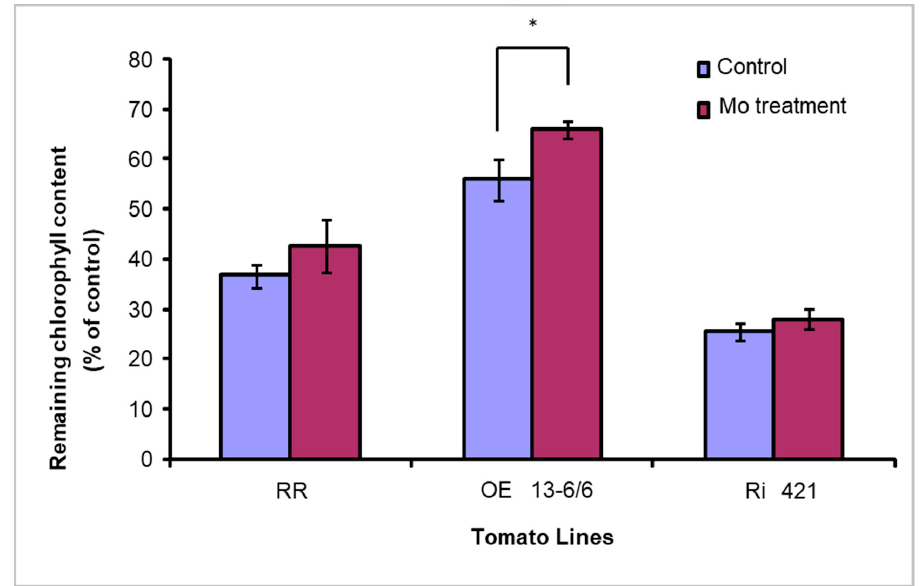
Figure 5. Remaining chlorophyll in Mo sprayed plants after sulfite treatment. Leaf discs from wild type (RR) and SO OE (OE 13-6/6) and SO Ri (Ri 421) tomato lines with and without Mo treatment were subjected to 0 mM and 7 mM Na 2 SO 3 for 24 h and the remaining chlorophyll content was expressed in percentage of control. Values are means ± SE ( n = 5). Means denoted with asterisk were significantly different ( p < 0.05) within the line.